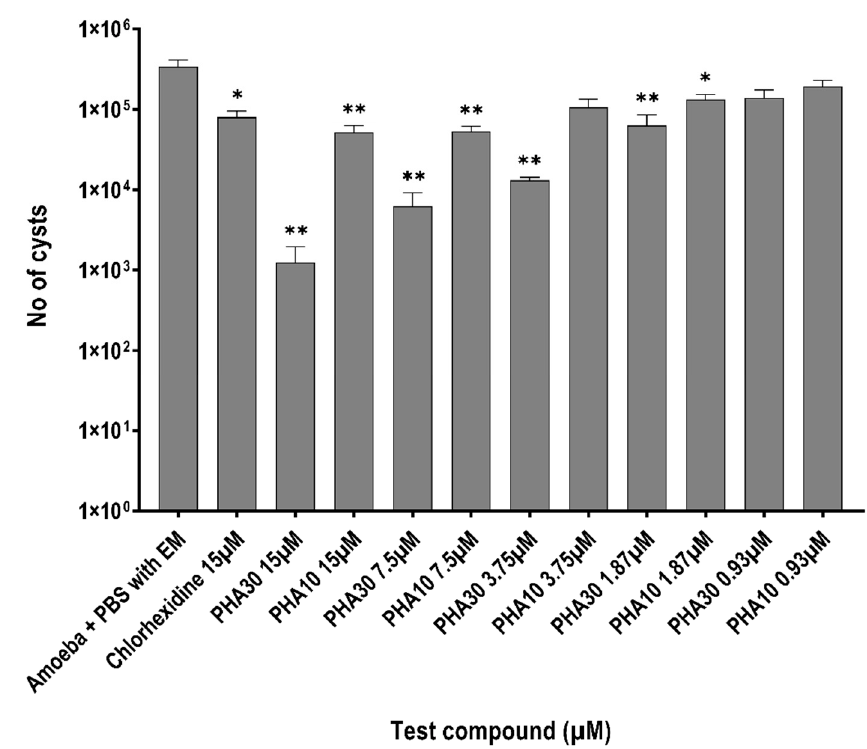
Figure 3. Inhibition of cysts formation by polyhomoarginine (PHA) peptides against A. castellanii ATCC30868. In brief, 5 × 10 5 A. castellanii trophozoites were incubated with PHA peptides and chlorhexidine at 30 °C for 72 h after which cysts were determined by solubilizing trophozoites adding 0.25% SDS. The Number of cysts was counted using the Neubauer haemocytometer. The results show significant anti-acanthamoeba activity when compared to the amoeba + PBS with encystment medium(EM) ** p < 0.001, * p < 0.05 using a two-sample t -test and two-tailed distribution).